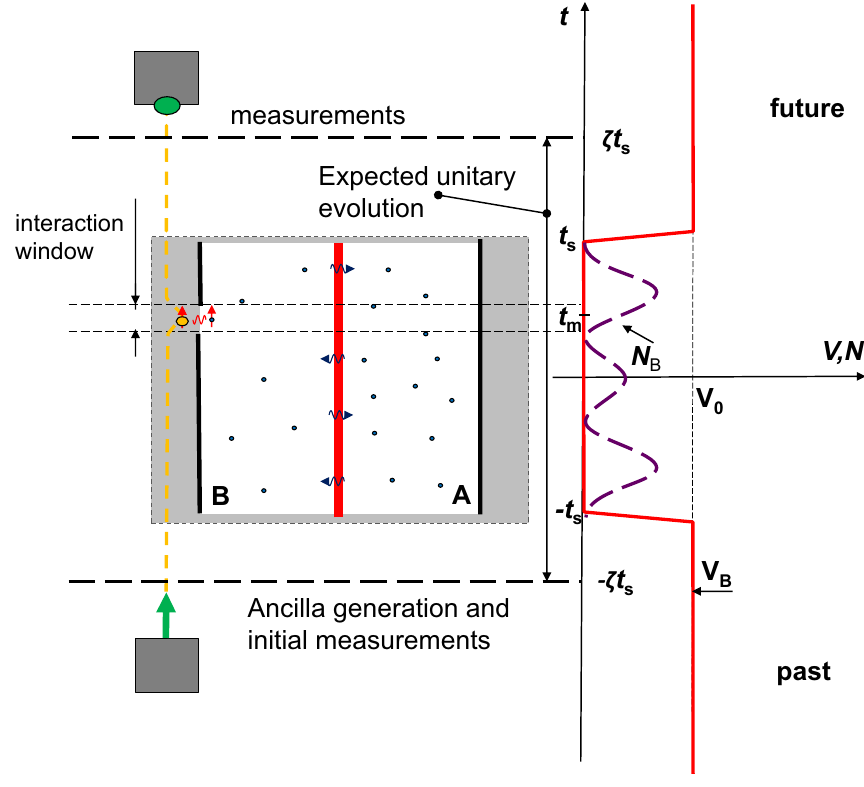
Fig. 2 Measuring presence of the working particles in sec- tion B: the projective measure- ments are conducted only on the ancilla system after the active phase of the experiment is completed. The evolution of the system is unitary during the active